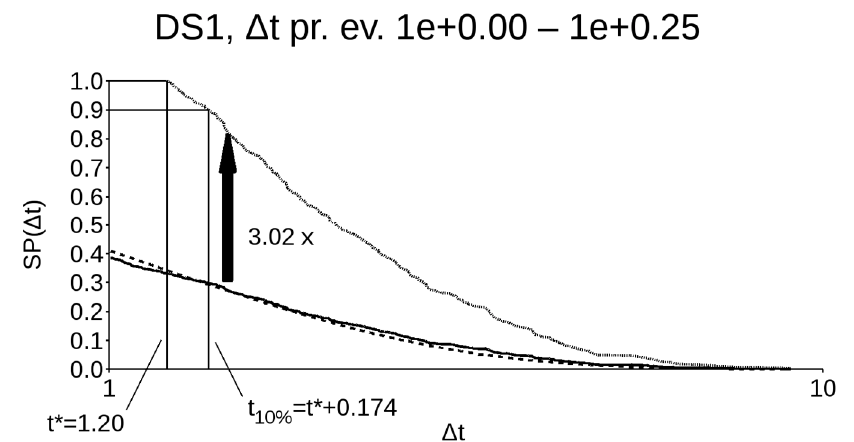
Figure 7. Method of computation of the 10% probability time interval at the elapsed time t ∗ , given a specific ∆ t between the last and the second-to-last event. The solid line refers to the empirical function, the dashed line refers to the Poissonian one, and the dotted line refers to the new, rescaled empirical one.